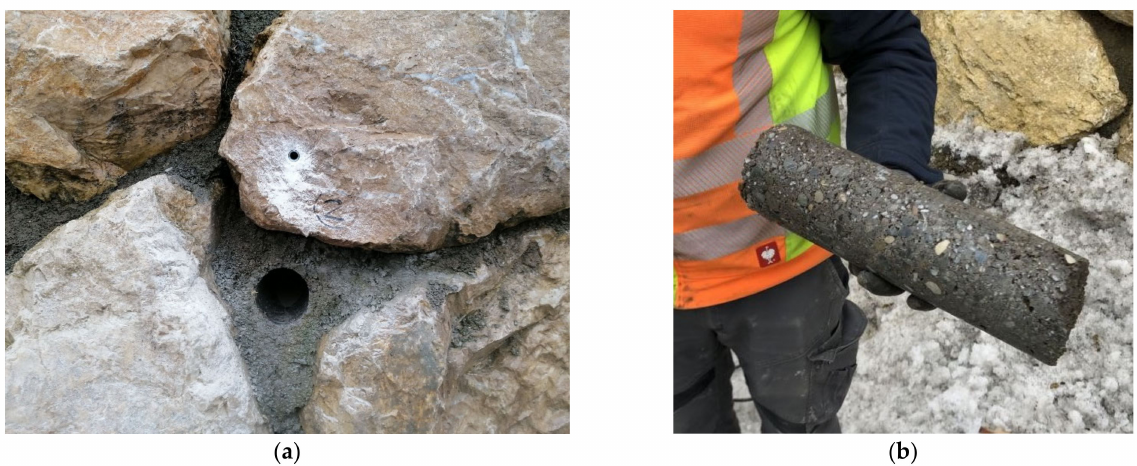
Figure 4. Drill core sampling from the existing supportive stone body ( a ) and extracted drill core for laboratory testing ( b